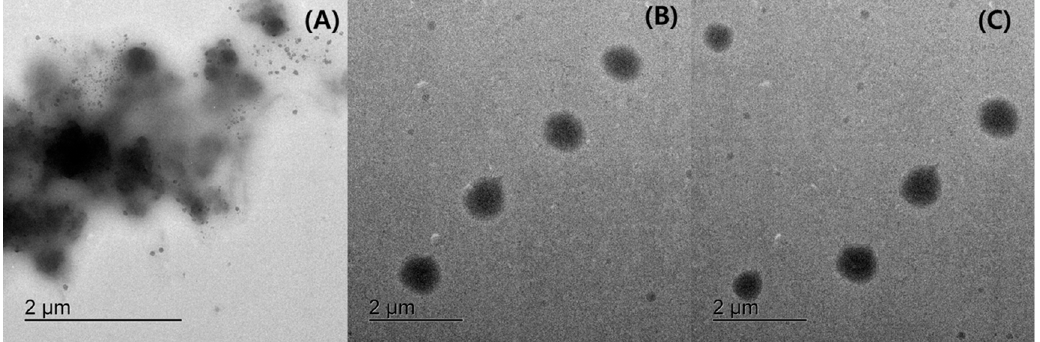
Figure 1. Transmission electron microscopy (TEM) images of ( A ) nonextruded AGN, ( B ) F1, and ( C ) F2. The scale bar represents 2 um.